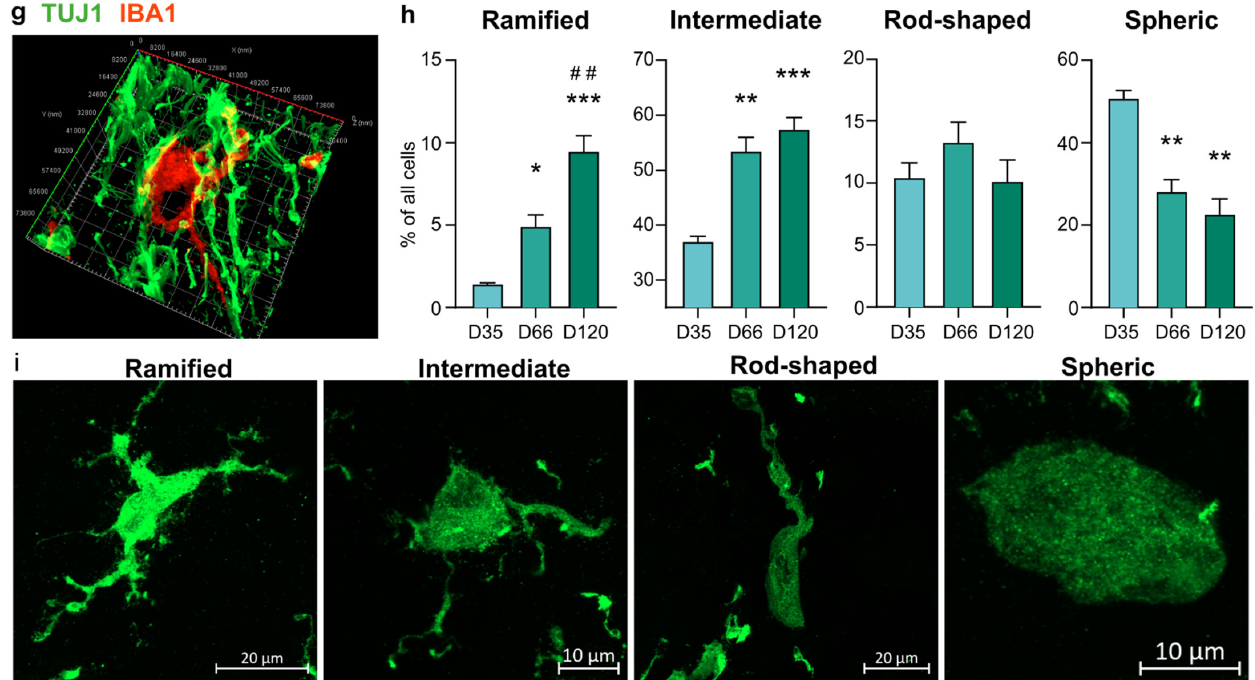
Figure 1. Erythromyeloid progenitors (EMPs) migrate to establish an IBA1+ population in cerebral organoids. ( a ) Schematic drawing depicting the introduction of EMPs to ORGs and subsequent experiments. ( b ) Immunohistological staining of IBA1+ cells colonizing a TUJ1 stained cORG at 120 days in vitro (DIV). ( c , d ) Immunohistological stainings of adjacent sections of an ORG 35 DIV, five days after incorporation of EMPs. TBR2+ and DCX+ cells show the formation of cortical loops, while CD41 shows the locus of incorporation and IBA1, the cells migrating from the locus to the vicinity of the nascent cortical loops. ( e ) A population of IBA1+ cells in taking different morphologies at 120 DIV. ( f ) Maturation of a cortical loop, as shown by immunostaining of SATB2 at 120 DIV. ( g ) A 3D reconstruction of an IBA1+ cell and its processes closely intertwined with TUJ1+ neurons at 66 DIV. ( h ) Detection and quantification of different morphology types of IBA1+ cells in organoids 35, 66 and 120 DIV, using the artificial intelligence platform by Aiforia. The Y-axis presents the portion of the respective morphology type in all the detected IBA1+ cells. The bars represent the mean (+/ − SEM) percentage of three organoids for the 35 DIV group (one batch), six for 66 (DIV (one batch) and nine for 120 DIV (two batches), Tukey test, significance *** p < 0.001, ** p < 0.01, * p < 0.05 compared to 35 DIV, ## indicate similarly significance compared to 66 DIV; ( i ) Representative orthogonal projection images of all the quantified morphology types, imaged from a single section of an organoid at 120 DIV. All results presented here come from organoids of the iPCS line MBE2968, while the qualitative results in panels ( b , e – g , i ) was replicated using the other three lines, MAD6, BIONi010-C-2 and Ctrl8